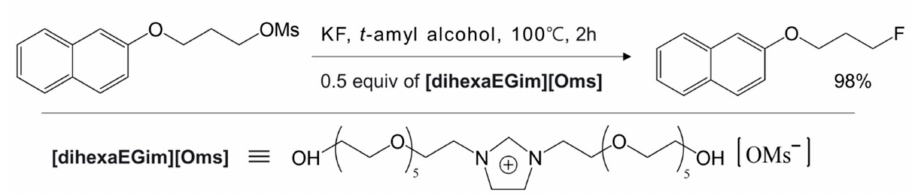
Figure 3. Promotion of S N 2 fluorination by oligoethylene glycol substituted imidazolium salts.